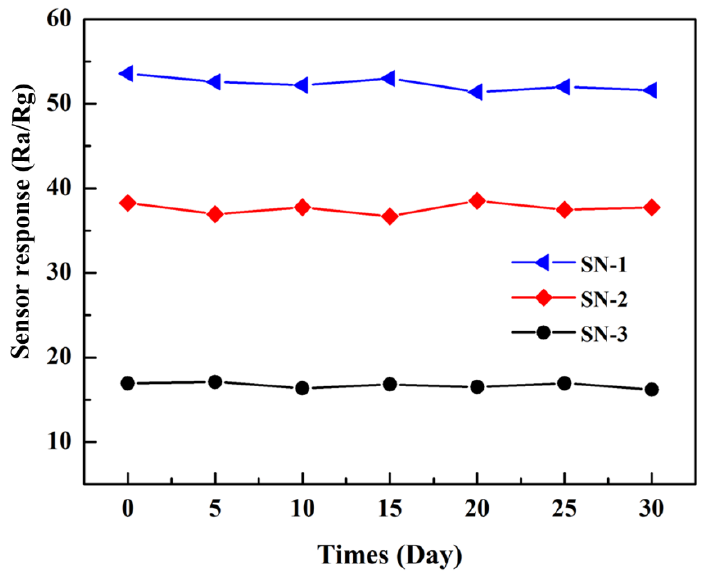
Figure 6. ( a ) Dynamic response and recovery curves of three SnO 2 samples relative to 50 ppm